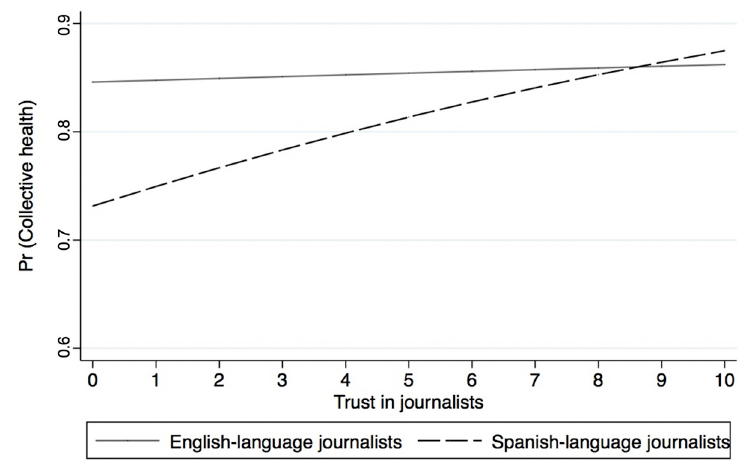
Figure 4. Predicted probability of supporting efforts to promote collective health by source credibil- ity.